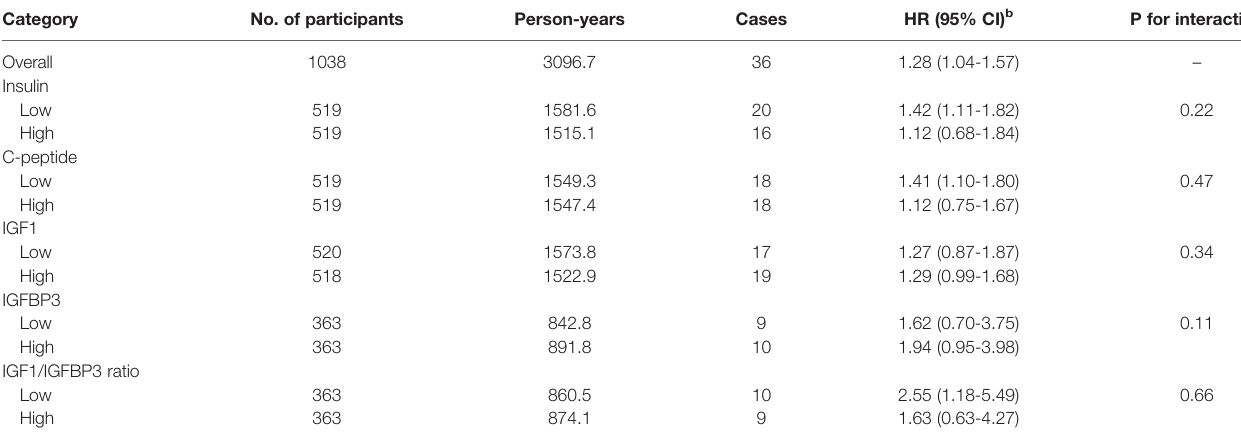
TABLE 3 | Associations of each 10-unit increase in the 21-gene RS with breast cancer recurrence by insulin and the IGF axis biomarker levels a .